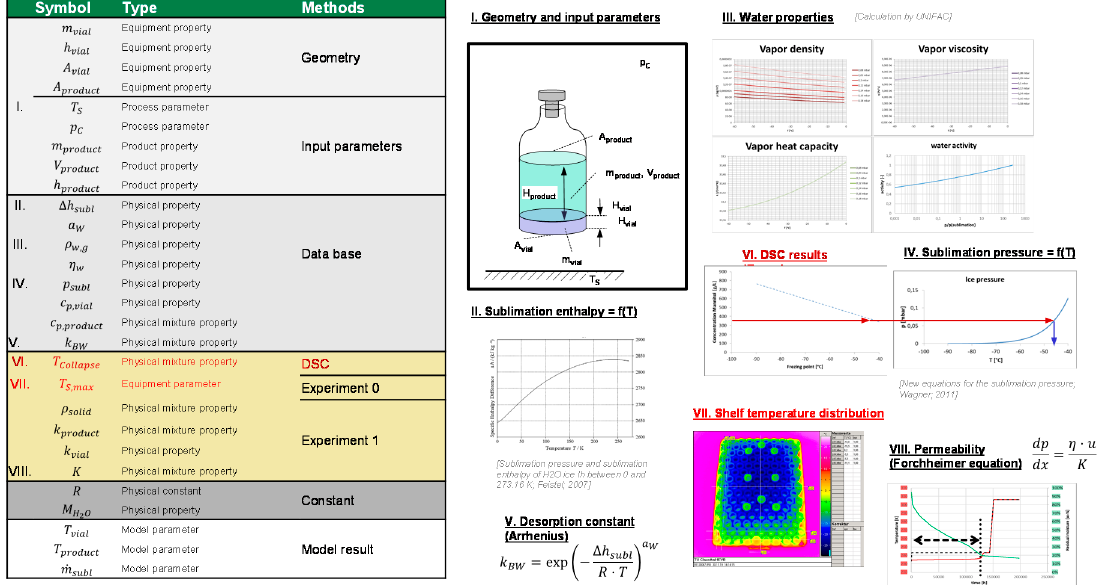
Figure 10. Model parameter determination concept overview.